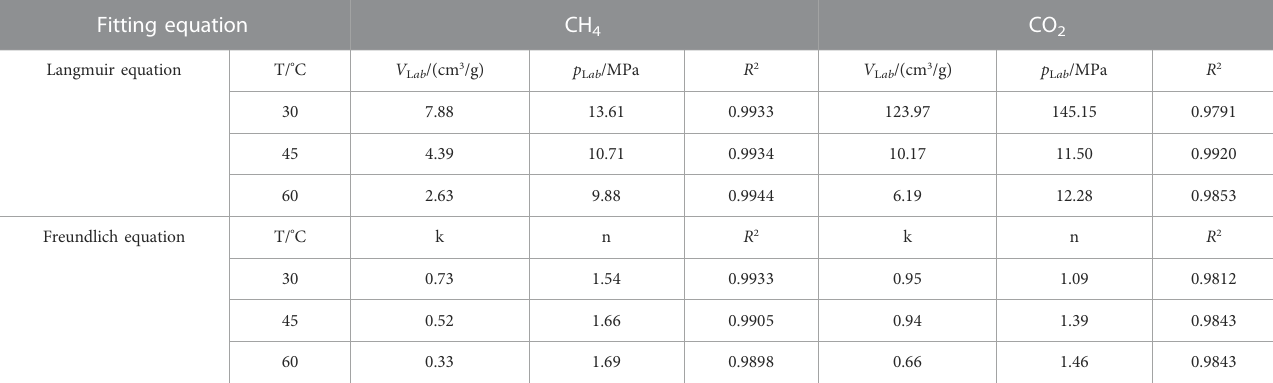
TABLE 3 The fi tting parameters of Langmuir and Frenudlich equations. Fitting equation Langmuir